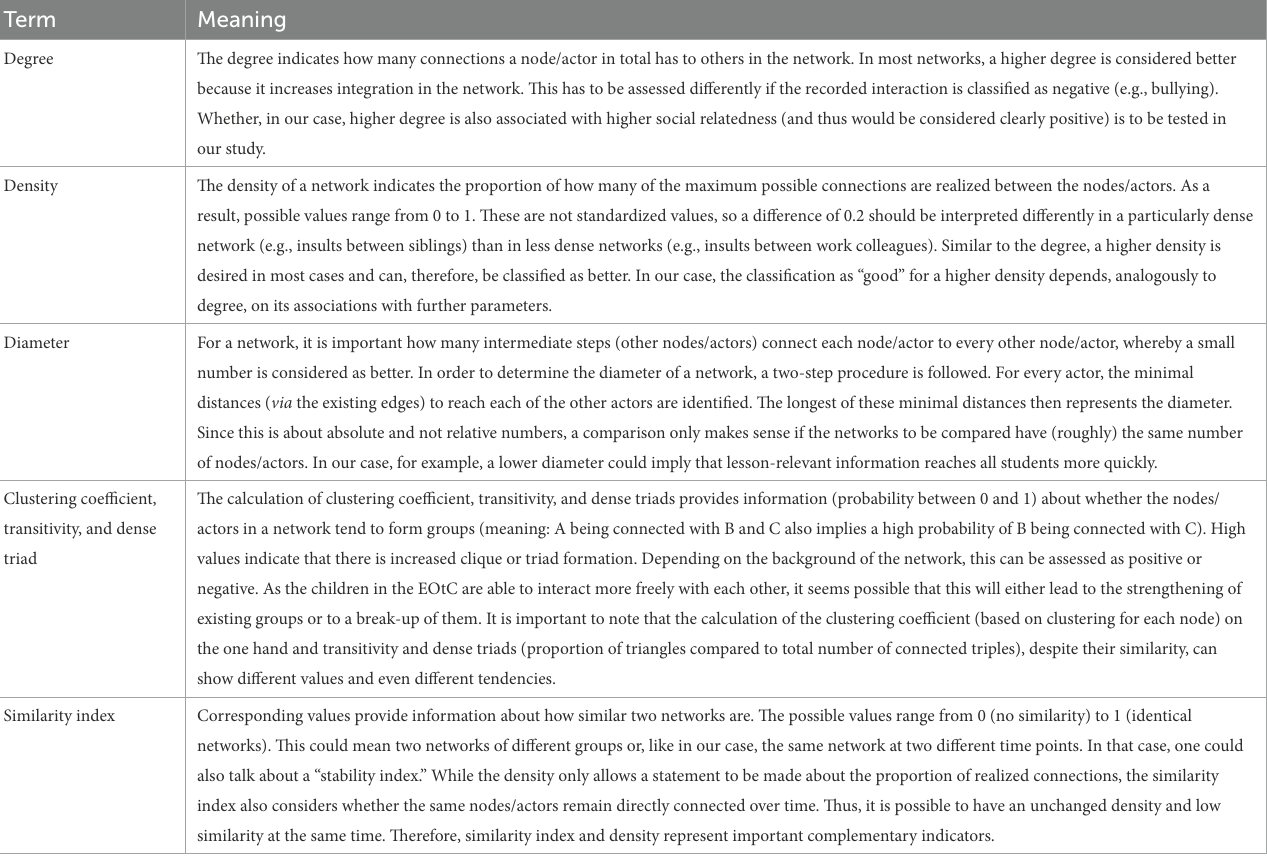
TABLE 2 Central terms in the interpretation of a social network and their meaning.